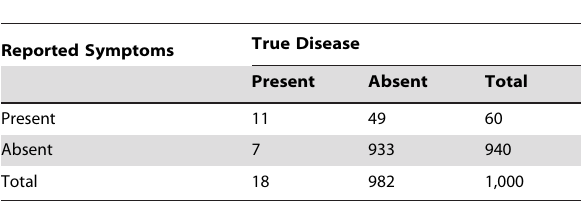
Table 5. Distribution of cases of ‘‘true pneumonia’’ according to caregiver report of ‘‘suspected pneumonia’’ (test) and true disease status when test sensitivity is 60% and specificity is 95%.